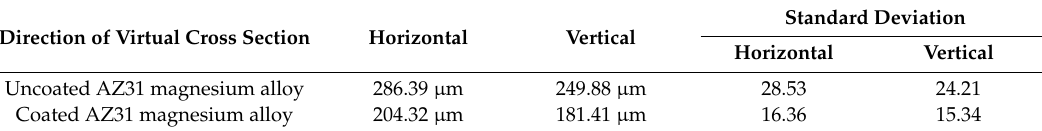
Figure 9. The virtual cross section of the crater of coated sample and its depth. Table 4. The comparison of the crater depth for the uncoated and coated sample.